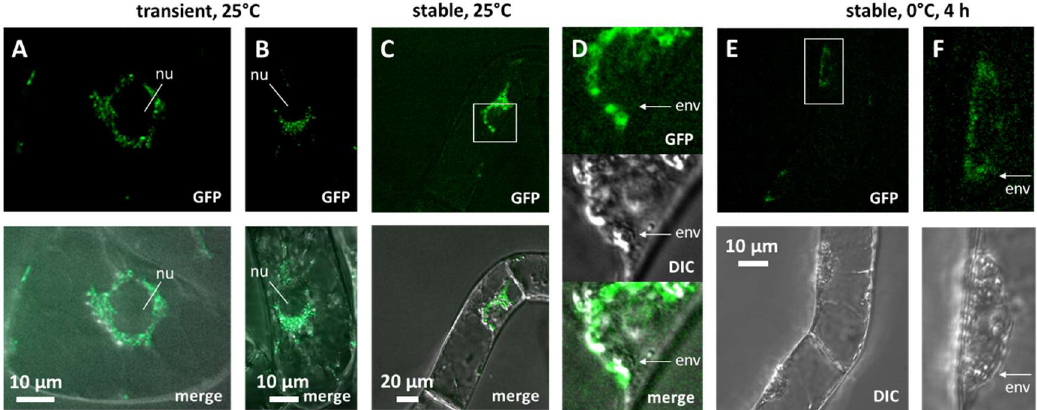
Figure 1. Subcellular localisation of VvCBF4 in fusion with GFP, assessed in tobacco BY-2 cells as a heterologous host. ( A , B ) transient transformation with a high-copy vector; cells incubated at 25 °C. For two representative cells, the GFP signals and the merge of the GFP signal with the differential interference contrast (DIC) are shown. Note that the GFP signal is localised outside of the nucleus (nu). ( C , D ) stable transformation with a binary vector; cells incubated at 25 °C. ( D ) shows a zoom- in of the region marked by a white square in ( C ). White arrows indicate the position of the nuclear envelope (env) separating karyoplasm and cytoplasm to show that the GFP signal is found outside of the nucleus. ( E , F ) stable transformation with a binary vector; cells incubated at 0 °C for 4 h. ( F ) shows a zoom-in of the region marked by a white square in ( E ). White arrows indicate the position of the nuclear envelope (env) separating karyoplasm and cytoplasm to show that, this time, the GFP signal is found inside of the nucleus.